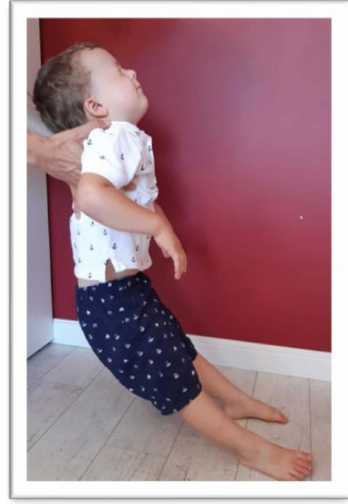
Figure 10. Position for the examination of the Moro reflex.